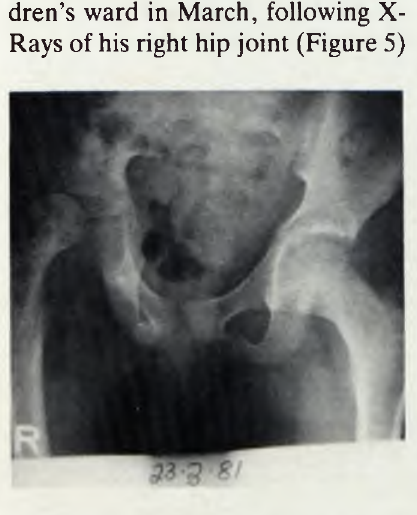
Figure 6. Right hip after operation in plaster of paris with Kushner pins in position.